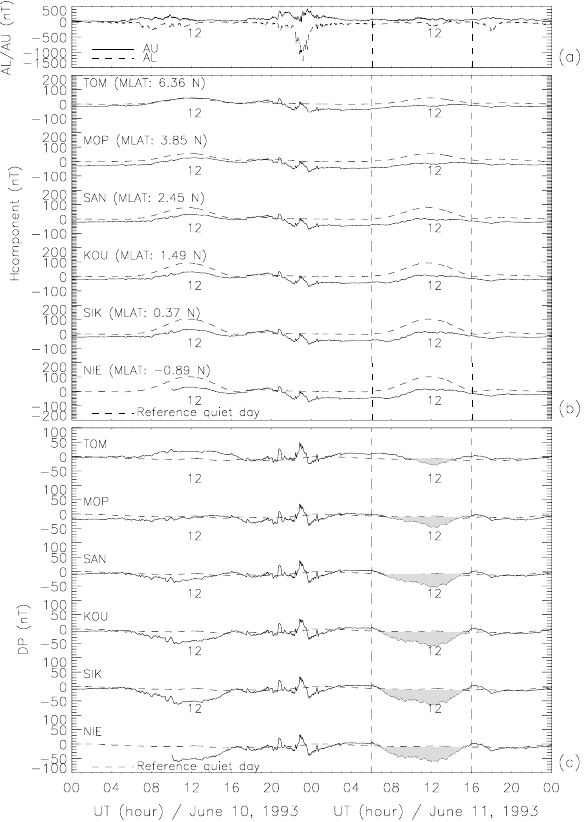
Fig. 3. Variation of the H component of the Earth’s magnetic field observed in the African equatorial stations (middle panel) and the corresponding disturbance DP (bottom panel), on 10, 11 June 1993 (solid line). The plots in dashed line indicate the variations of the reference quiet day. On the top panel, the variations of the AU and AL indices are represented. The local time is the same as the universal time in these stations and local noon is indicated on the plots.